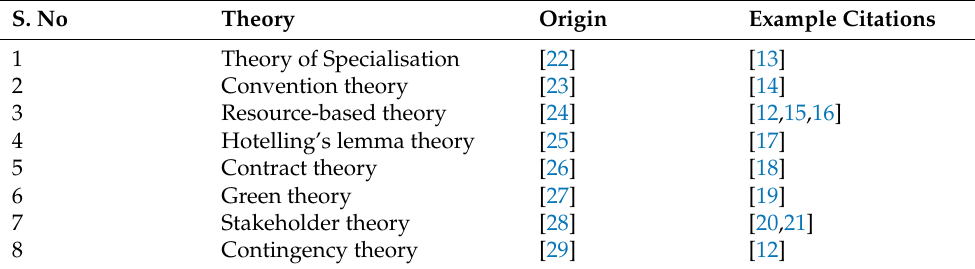
Table 2. Theories Employed, Source: The